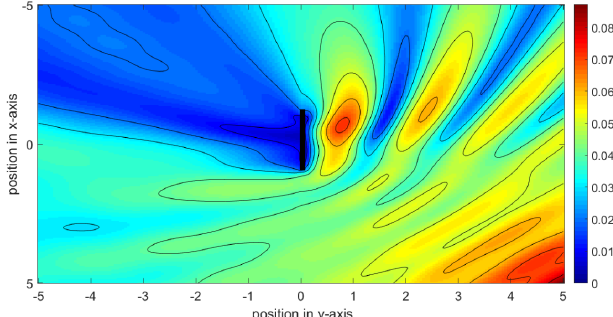
Figure 5: The Amplitude of the Total Electric Field 𝐸Q⃗ AN for 𝑎 = 1 , 𝜖 = 𝜋 , 𝑥